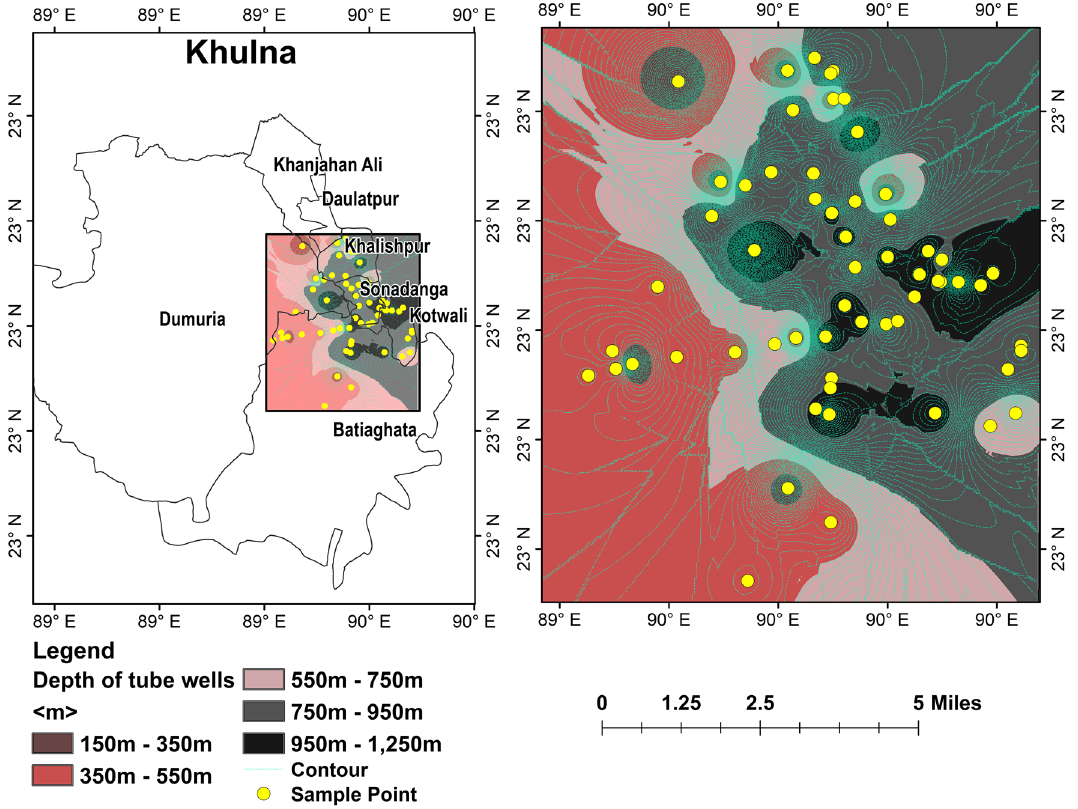
Fig. 2 Depth wise distribution of the tube wells selected for